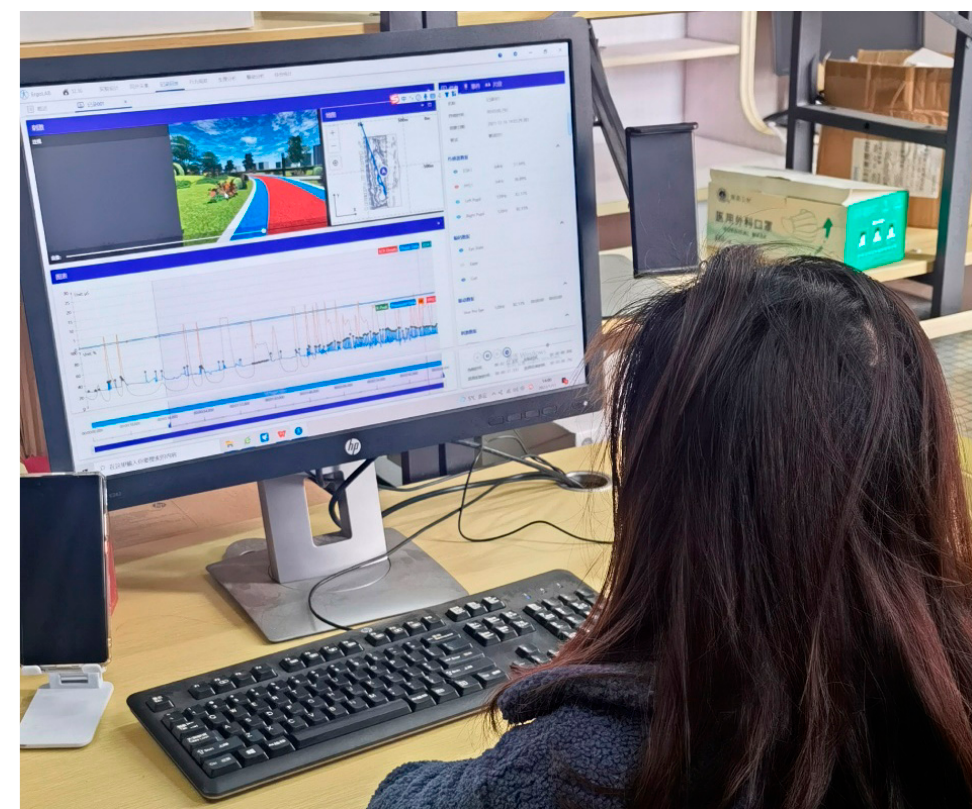
Figure 2. Experimental scene.